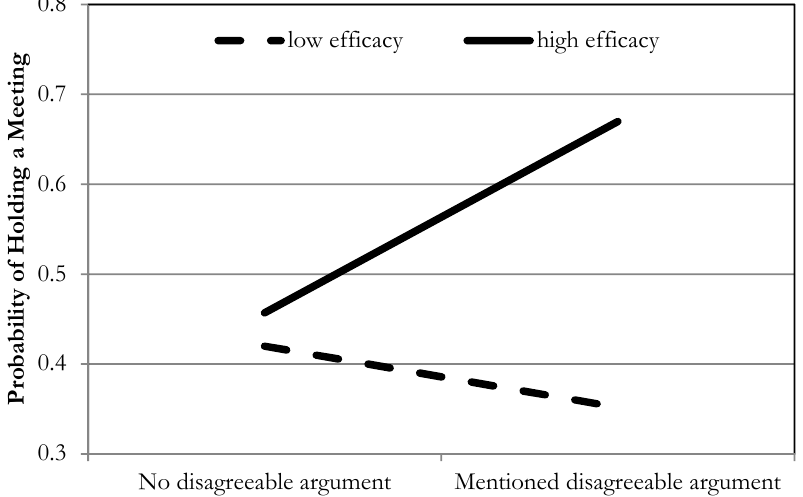
Figure 2 : Interactive Effect of Clergy Efficacy and Mentioning a Disagreeable Argument on Holding a Congregational Meeting about the ELCA